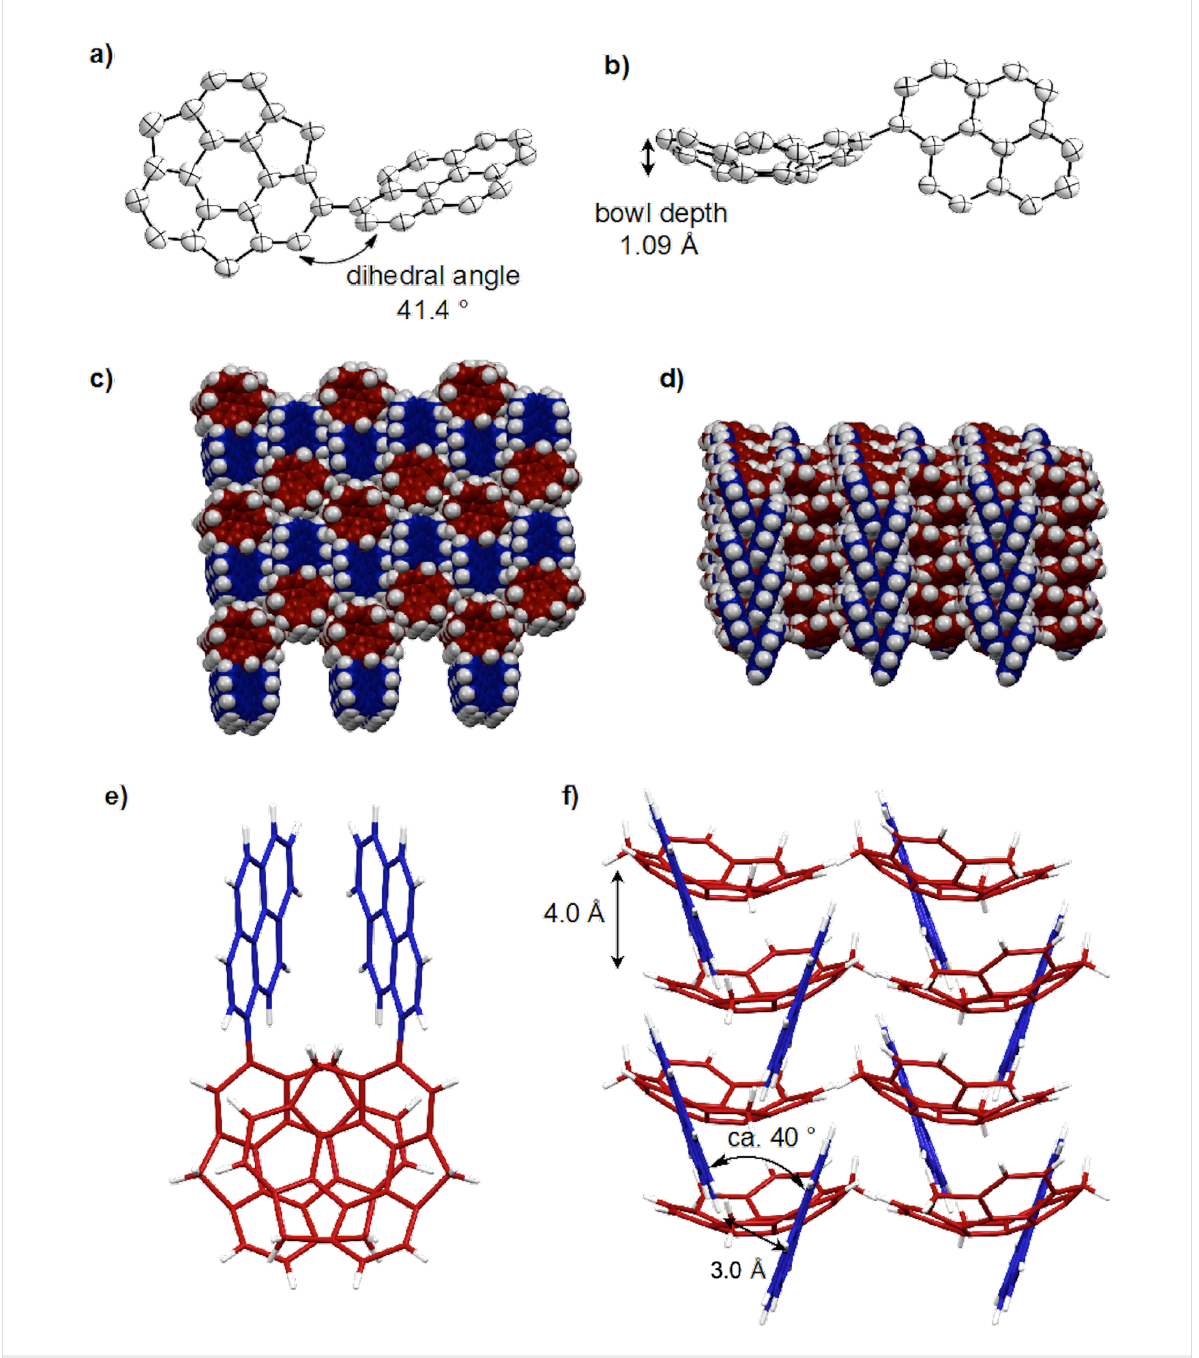
Figure 2: The X-ray crystal structure of 1 , showing: (a) top view of the ORTEP drawing with 50% probability, b) side view, c) top view of the packing structure with the sumanene bowl in red and the pyrene substituent in blue, d) side view, e) top view of column stacking of enantiomers and f) side view of columns with a herringbone packing of the pyrene moiety due to CH– π interactions.